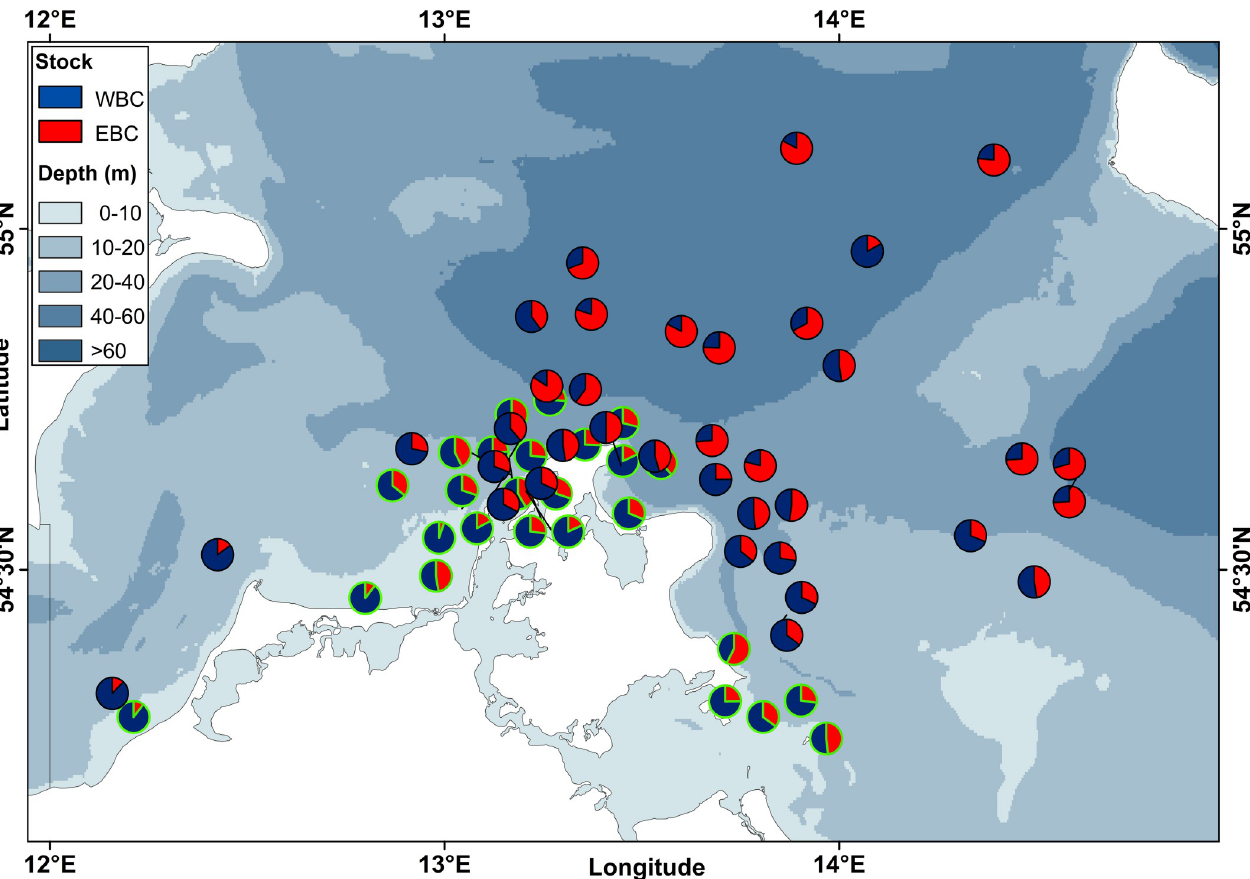
Fig 5. Spatial distribution of stock mixing proportions in SD 24. Mixing proportions of WBC and EBC are based on cod samples from German commercial catches between 2010 and 2019. Samples from active and passive gear fisheries are marked with black and green outlines, respectively. Only fishing hauls with � 50 individuals are shown (N total = 10 631 otoliths from 62 sampled